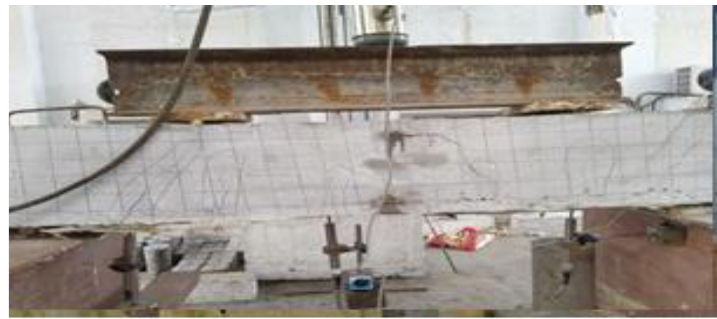
Figure 15. Crack pattern for Beam 2.